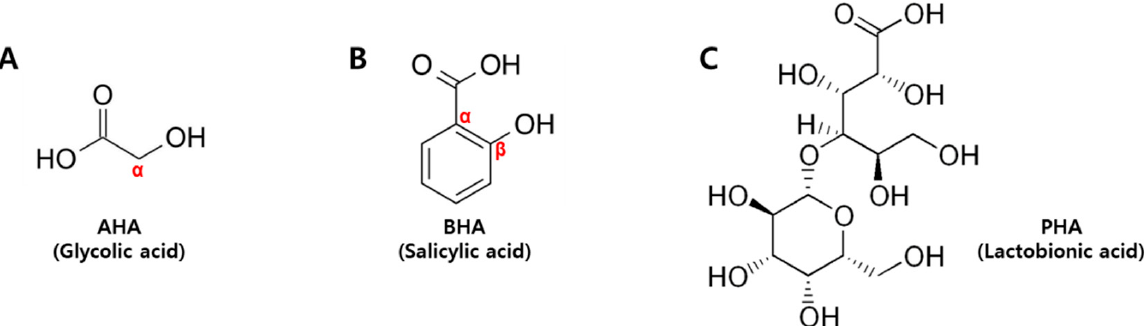
Figure 1. Classification of hydroxyacids used in this study ( A ) AHA (glycolic acid), ( B ) BHA (salicylic acid), and ( C ) PHA (lactobionic acid). AHA: α -hydroxyacid, BHA: β -hydroxyacid, PHA: polyhydroxyacid.